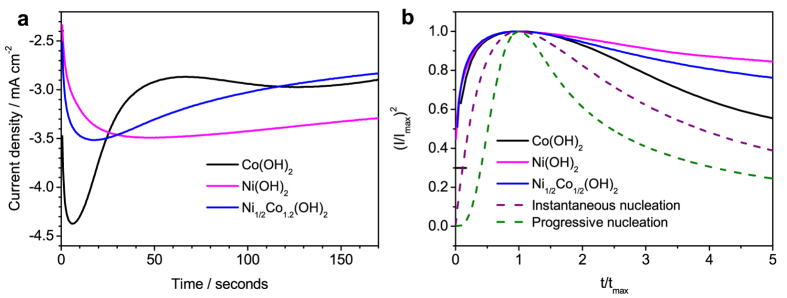
(a) Current transients of Co(OH)2, Ni(OH)2 and Ni1/2Co1/2(OH)2 electrodeposition and (b) the corresponding (I/Imax)2 vs. t/tmax curves obtained by changing coordinates of these current transients.